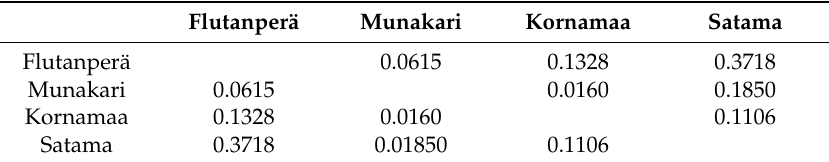
Table 12. The calculated JM-distances between reed sites.